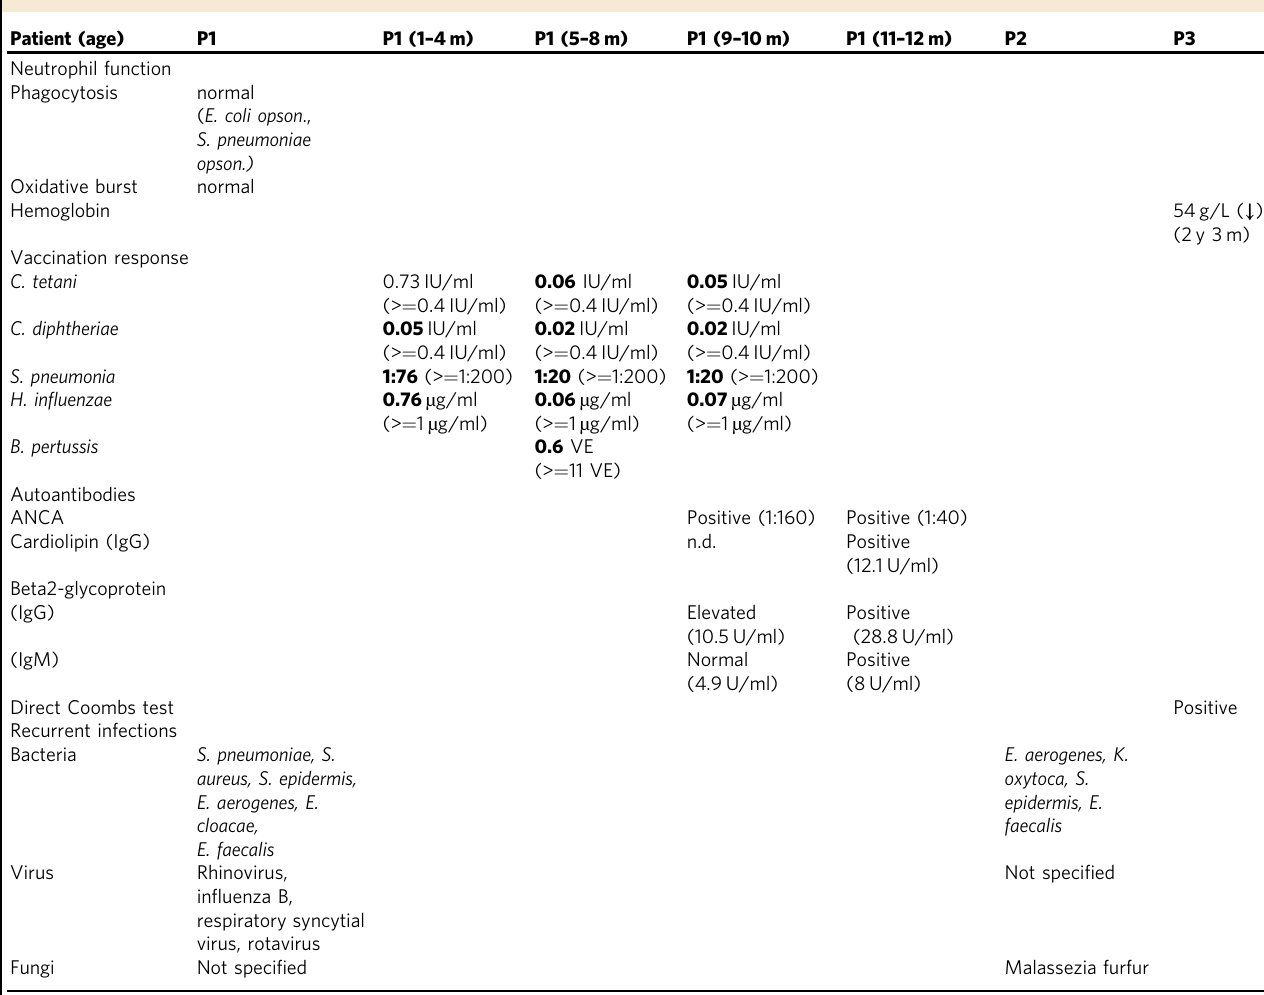
Table 2 Clinical characteristics of patients with DEF6